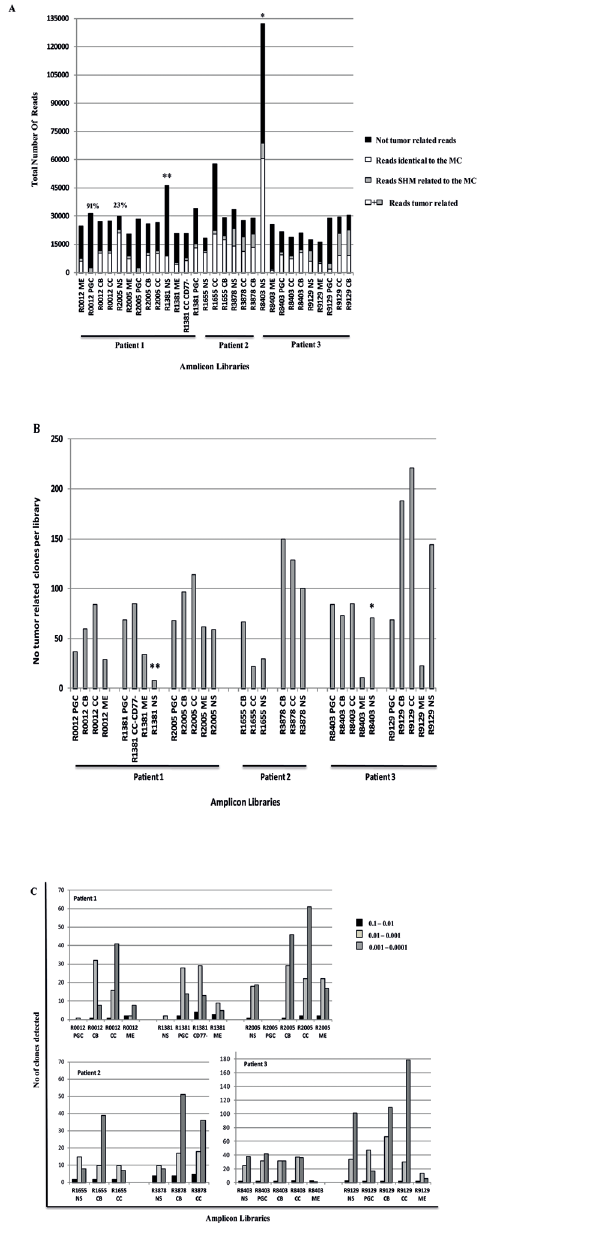
Fig 3. High throughput sequencing results and analysis of the tumor related clone. (A) Histogram showing the tumor related reads generated in the 29 different sub-sets that passed the filtering process. In black are shown the not tumor related reads, generated using VH3 family primers (S1 Table), in white the reads identical to the MC and in grey reads that are clonally related to the MC. * indicates the library prepared performing 6 independent PCRs, using the same primer whilst ** prepared by performing 2 independent PCR and using 2 different MID primers (B) Histogram showing the number of MC related subclones generated per library. * symbol indicates the library prepared by performing 6 independent PCRs with the same primer whilst ** symbol refers to the library prepared by performing 2 independent PCR and using 2 different MID primers. (C) Histogram showing the frequency of the clones per library. The black squares represent the number of clones detected at a frequency between 0.1 and 0.01, the dark grey squares the clones detected at a frequency between 0.01 and 0.001 and the light grey squares the number of clones detected at a frequency between 0.001 and 0.0001.